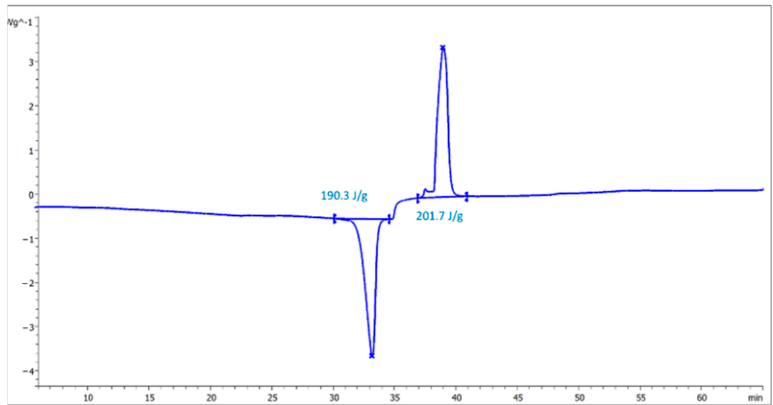
Figure 4. DSC Latent heat evaluation of the ternary PCM eutectic.